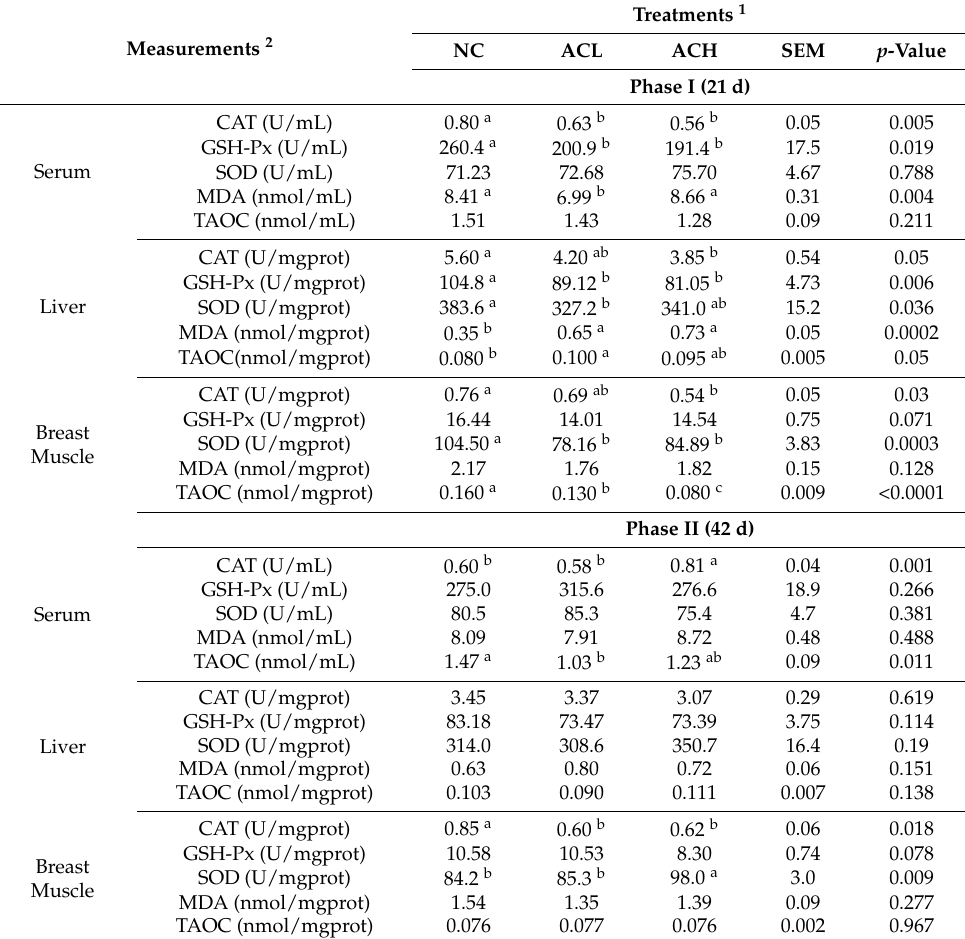
Table 6. Effect of different levels of aging corn on the oxidative ability of serum, liver, and breast muscle in